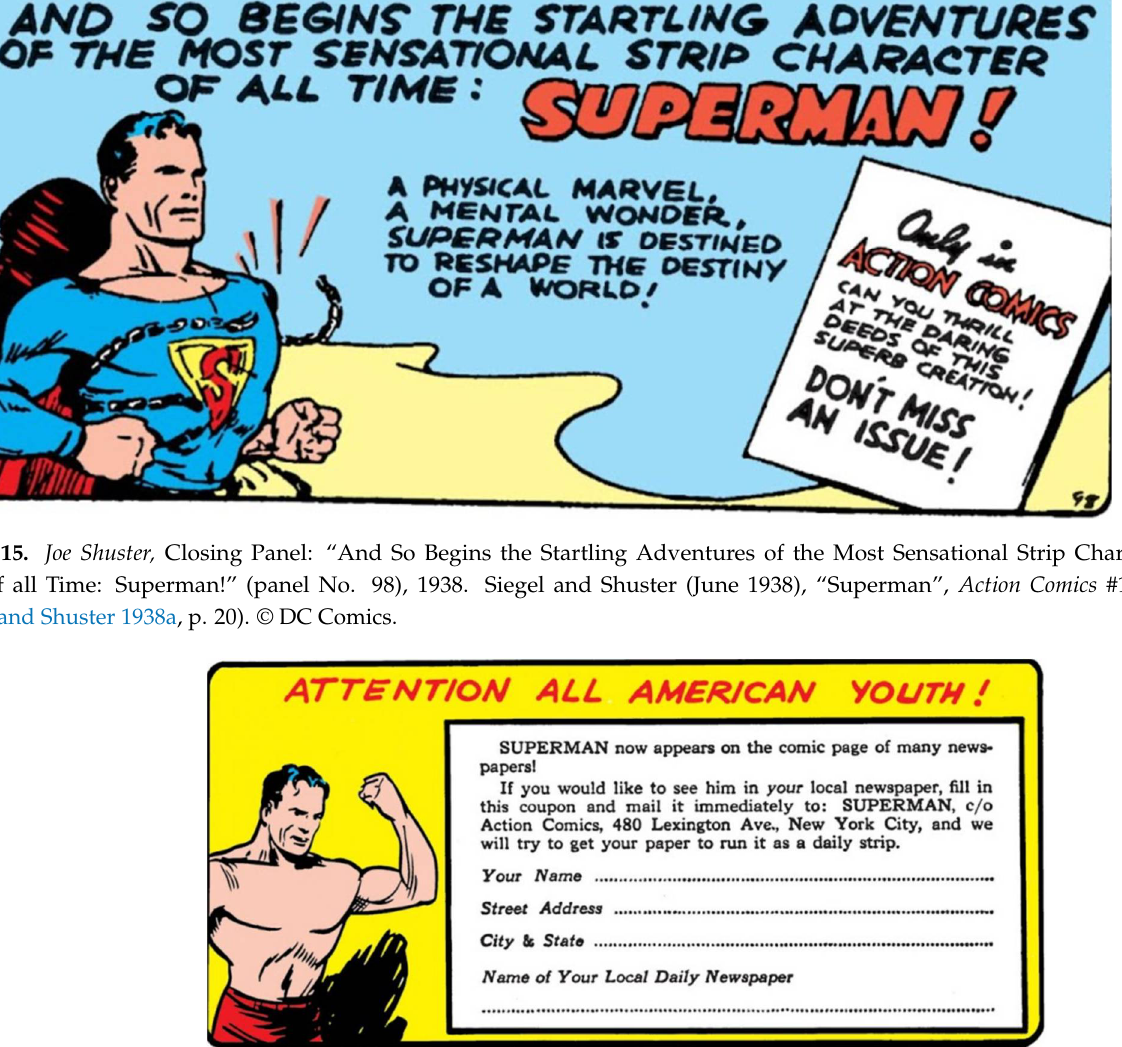
Figure 17. Joe Shuster, Closing Panel: “Hey Fellers!” (panel No. 96), 1938. Siegel and Shuster (August 1938), “Superman”, Action Comics #3 (Siegel and Shuster 1938c, p. 48). © DC Comics.